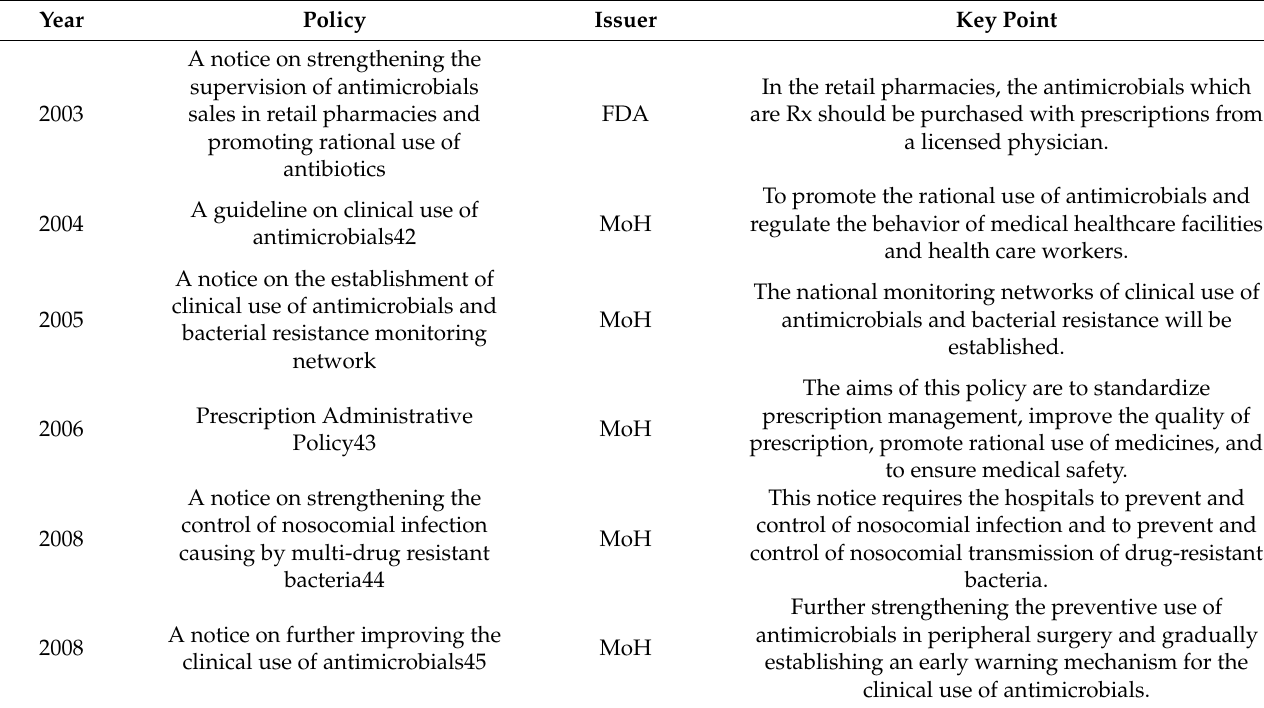
Table 2. Policy and regulation milestones on AMR control in China at stage